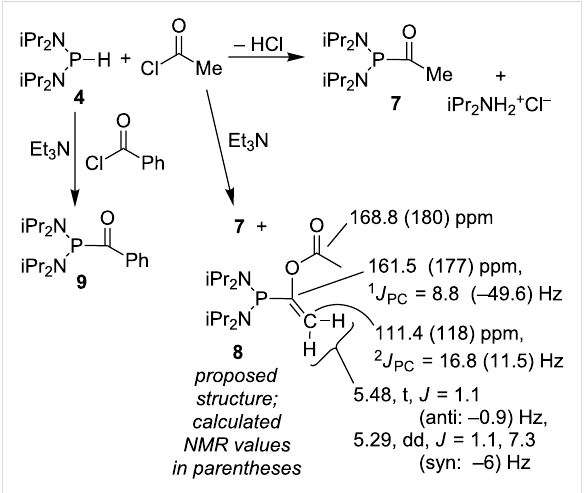
Scheme 2: Reaction of an H -phosphonodiamidite with acid chlorides.